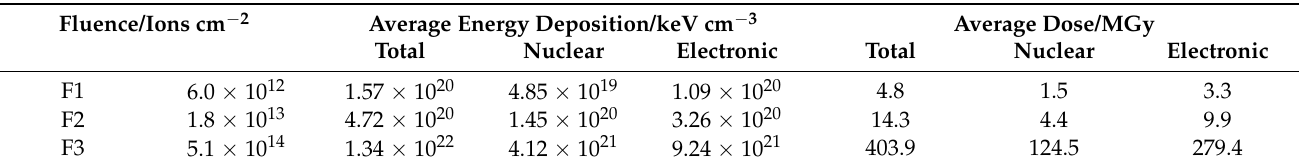
Table 3. Average energy deposition and doses during triple-energy irradiation of SmPO 4 with Au ions (1, 3.5, 7 MeV).